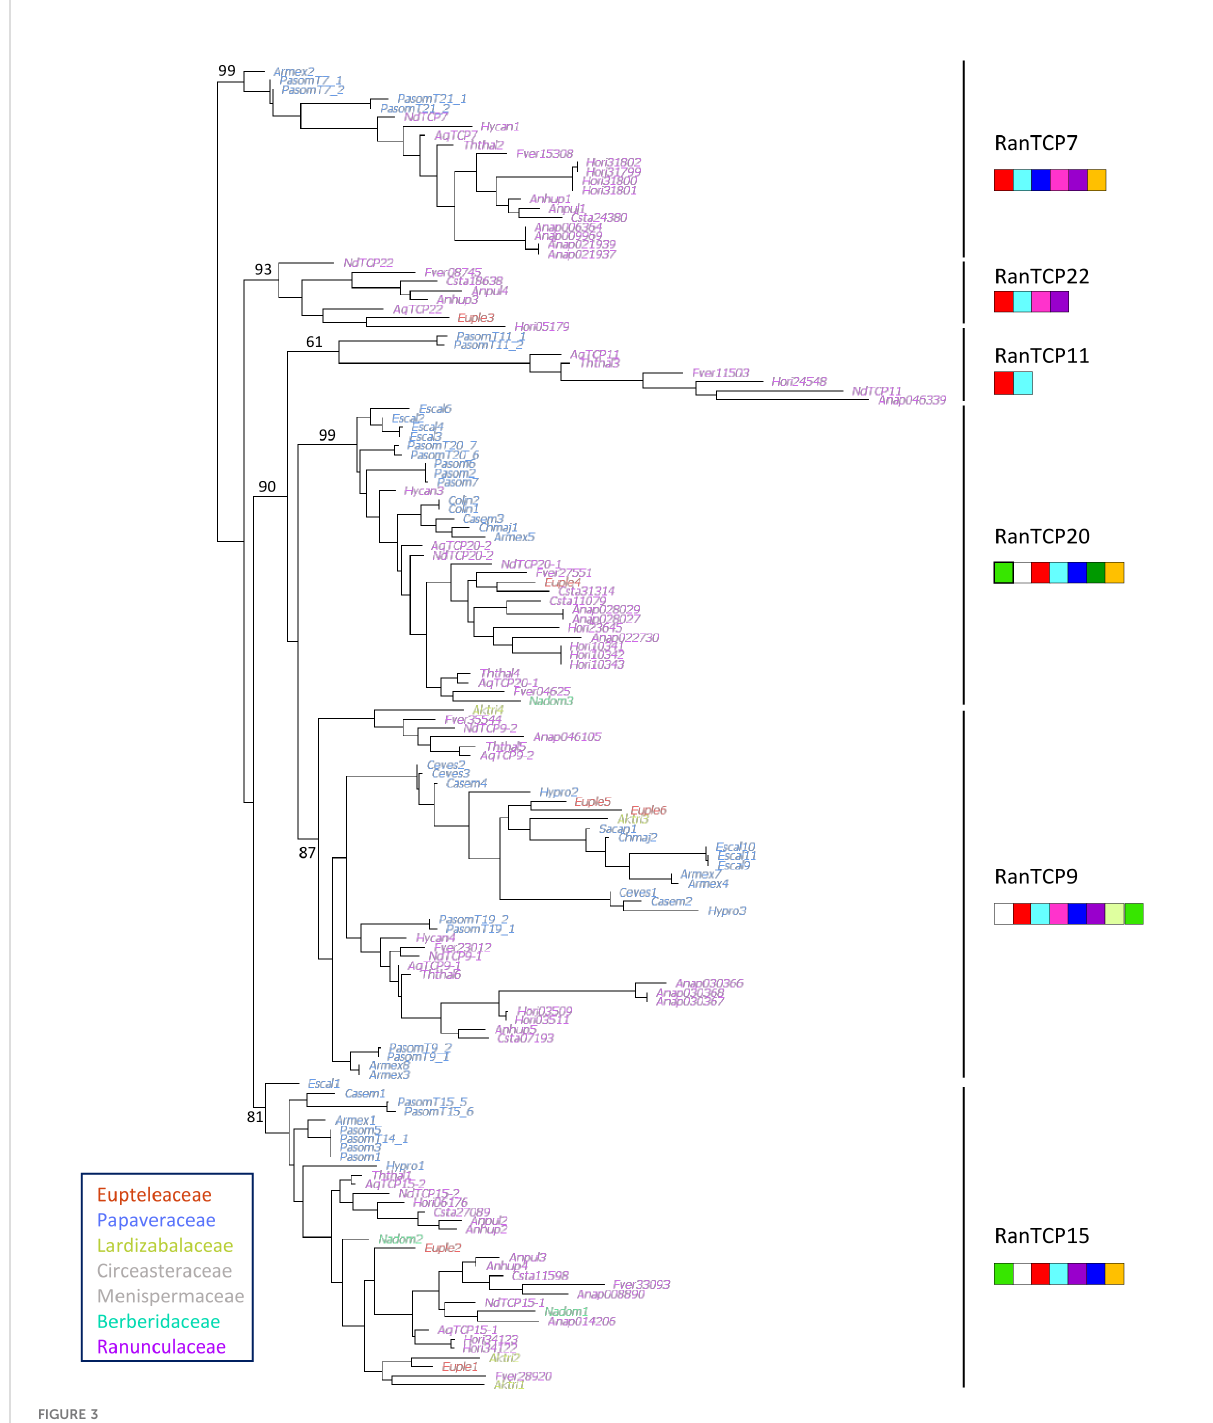
FIGURE 3 Phylogeny of 145 class I TCP coding nucleotide sequences from Ranunculales. Ranunculales families were color-coded as indicated (no sequences were available for Circeasteraceae and Menispermaceae, in grey). Support values (a-LRT x100) are given for the main branches, corresponding to the six groups identi fi ed in Figure 1. The speci fi c combinations of amino acid motifs that characterize the six groups are drawn under each group name. A motif is represented if it is found in at least half of the sequences in that group. Red: M I R 1; light blue: M I R 2; mid green: M I R 3; violet: M I R 4; yellow: M I R 5; dark green: M I R 6; dark blue: M I R 7; pink: M I R 8; white: M I R 9; yellow green: M I R 10 (motifs de fi ned in Supplementary Figure